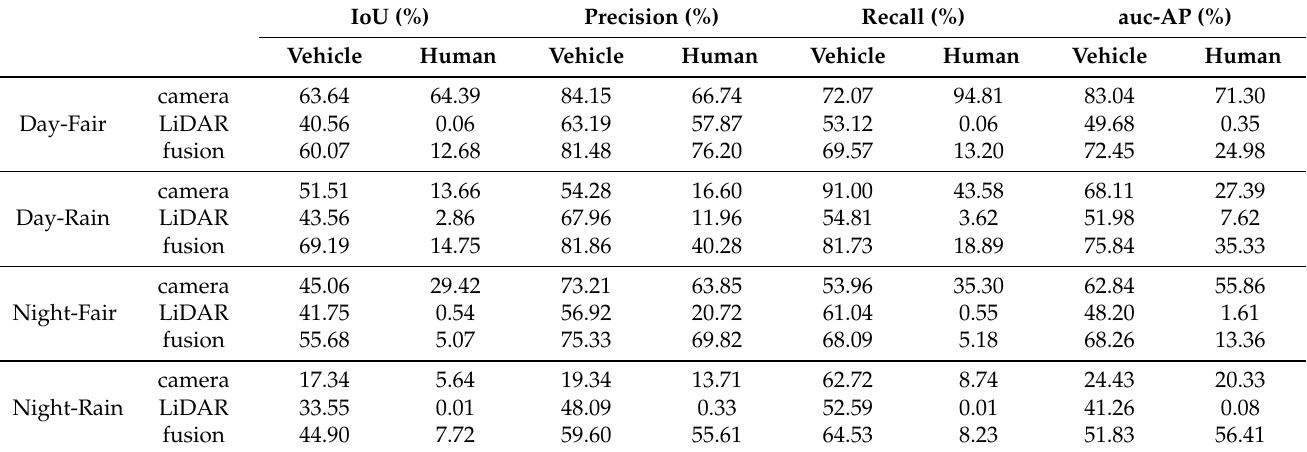
Table 3. Performance of supervised learning Waymo baseline models tested by the iseAuto